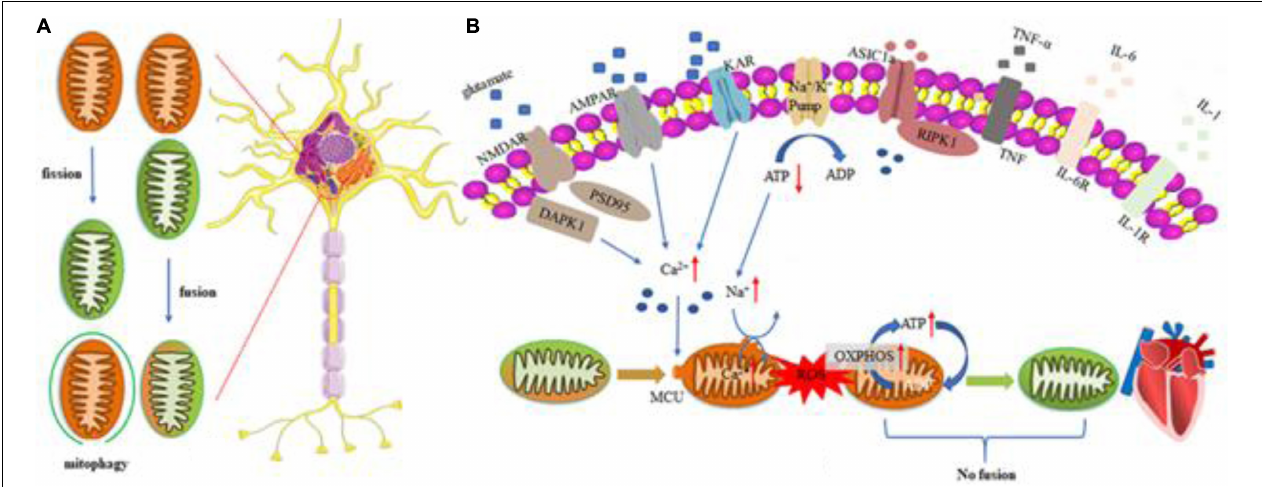
FIGURE 1 | Regulation mechanism of MQC in cardiovascular disease. Mitochondrial response includes excessive ROS production, mitochondrial calcium overloading, and disrupted MQC. Excessive glutamate release and impeded reuptake of excitatory amino acids result in the activation of NMDARs, AMPARs, and KARs, as well as inflammatory reaction. Microglia are activated and release cytokines and chemokines to induce inflammation reaction. All factors mentioned above function synergistically to trigger cell death pathways such as apoptosis, necroptosis, and autophagy. (A) Regulatory mechanisms of Mitochondrial fusion/fission and mitophagy in cells. (B) Heart impaired mitophagy resulting in the development of dilated cardiomyopathy. Myocardial cells can reduce ROS production by activating mitochondrial autophagy, prevent mitochondrial permeability transition pores (mPTPs) from opening, improve mitochondrial quality and ensure its basic energy requirements. If the level of mitochondrial autophagy is reduced, the damaged mitochondria will clear away the obstacles in the cells and excessively accumulate, which will induce myocardial apoptosis and damage. ROS, reactive oxygen species; AMPAR, α -amino-3-hydroxy-5-methyl-4-isoxazole-propionic acid receptor; NMDAR, N-methyl-D-aspartate receptor; KAR, kainite receptor; DAPK1, death associated protein kinase 1; PSD95, postsynaptic density protein 95; ASIC1a, acid-sensing ion channel 1a; RIPK1, receptor interacting protein kinase 1; TNF- α , tumor necrosis factor- α ; IL-6, Interleukin 6; IL-1, Interleukin 1; OXPHOS, oxidative